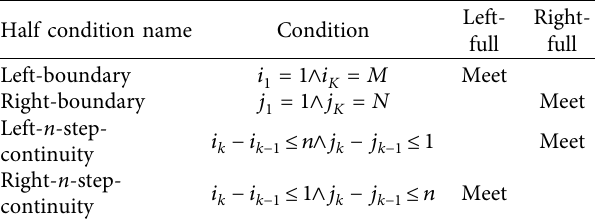
Table 2: The relationship between various generalized conditions.